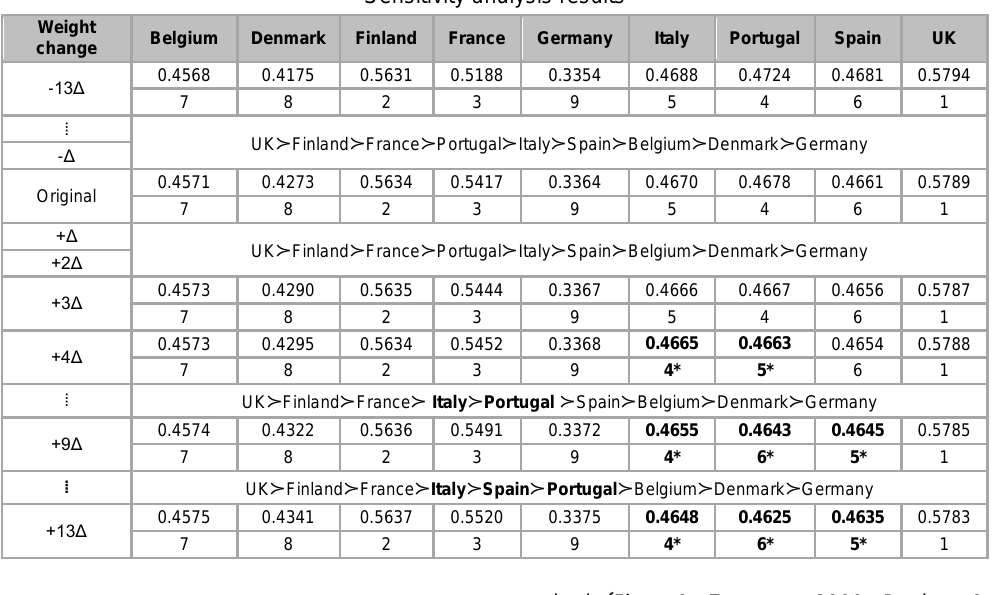
Sensitivity analysis